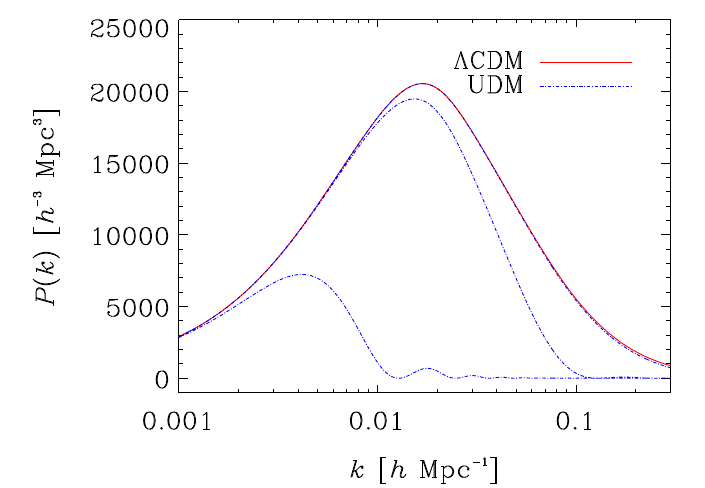
Fig. 49 The z = 0 matter power spectrum arising in UDM models with a Lagrangian given by Eq. (II.9.4). Λ CDM is solid, and UDM models with c ∞ = 10 − 1 , 10 − 2 , 10 − 3 are shown from bottom to top. Image reproduced by permission from Camera et al. (2011c), copyright by the